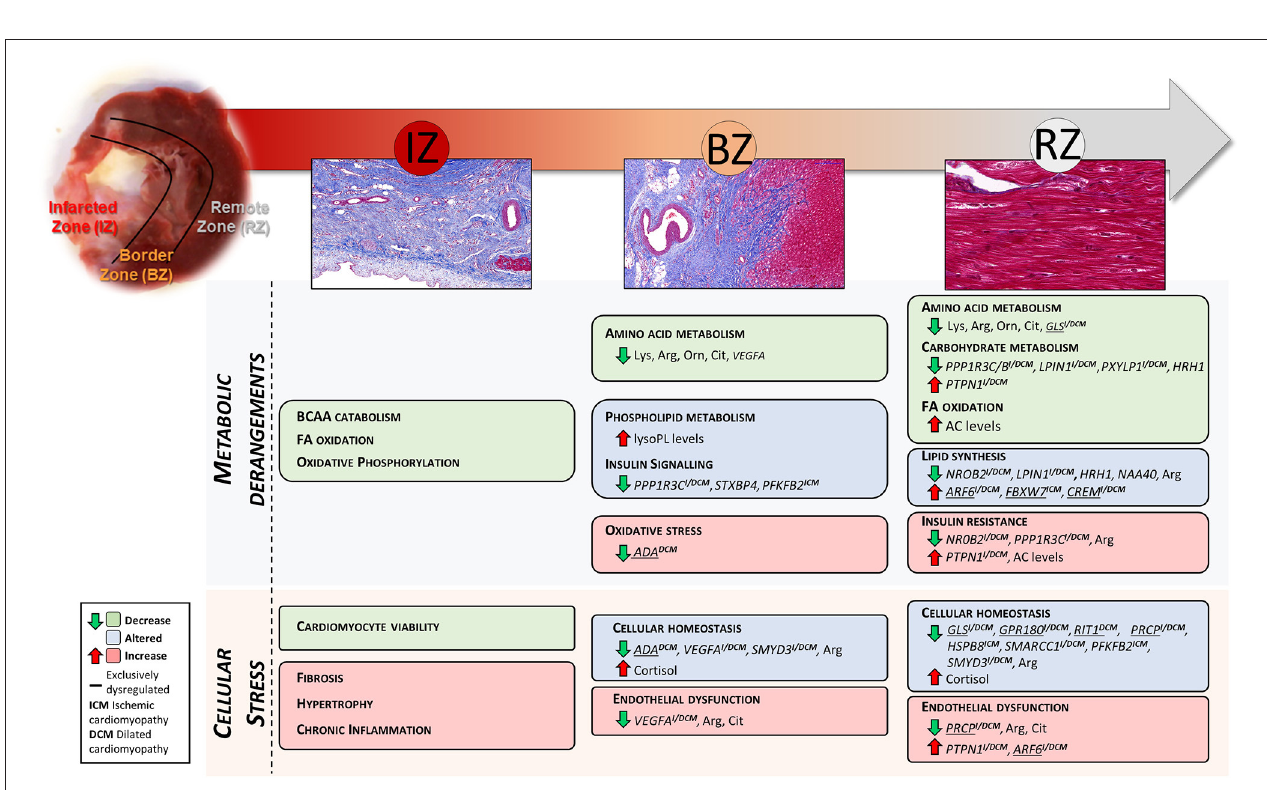
Supplementary Table 1 . (D) Heatmap illustrating genes involved in metabolic functions, found significantly dysregulated in both pig post-MI and human ICM/DCM datasets. For comparison of the expression levels between datasets please see Supplementary Table 7 . (E) Heatmap illustrating Spearman’s rank correlation